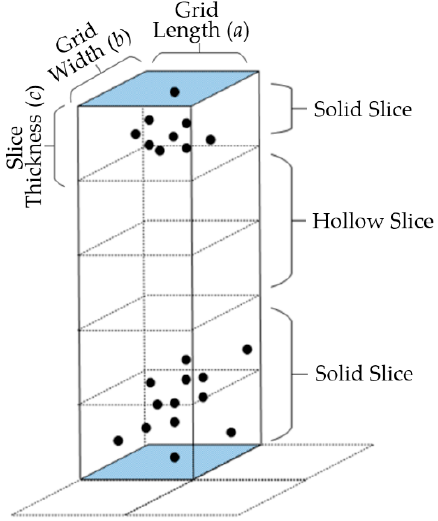
Figure 2. Vertical space slice.